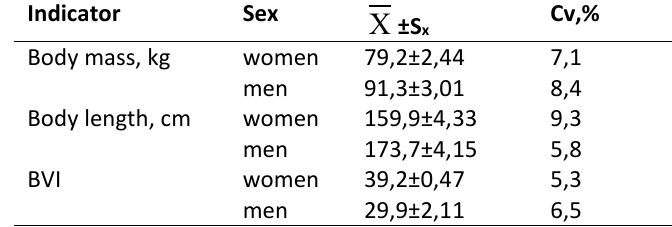
Table 2. Anthropometric indicators and body mass indices, depending on sex of respondents